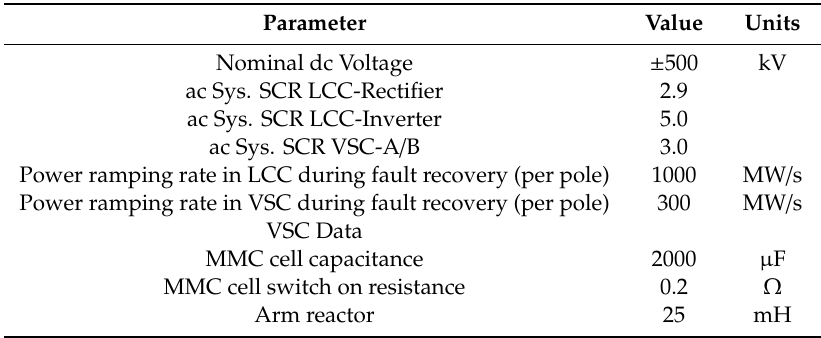
Table 1. Test system